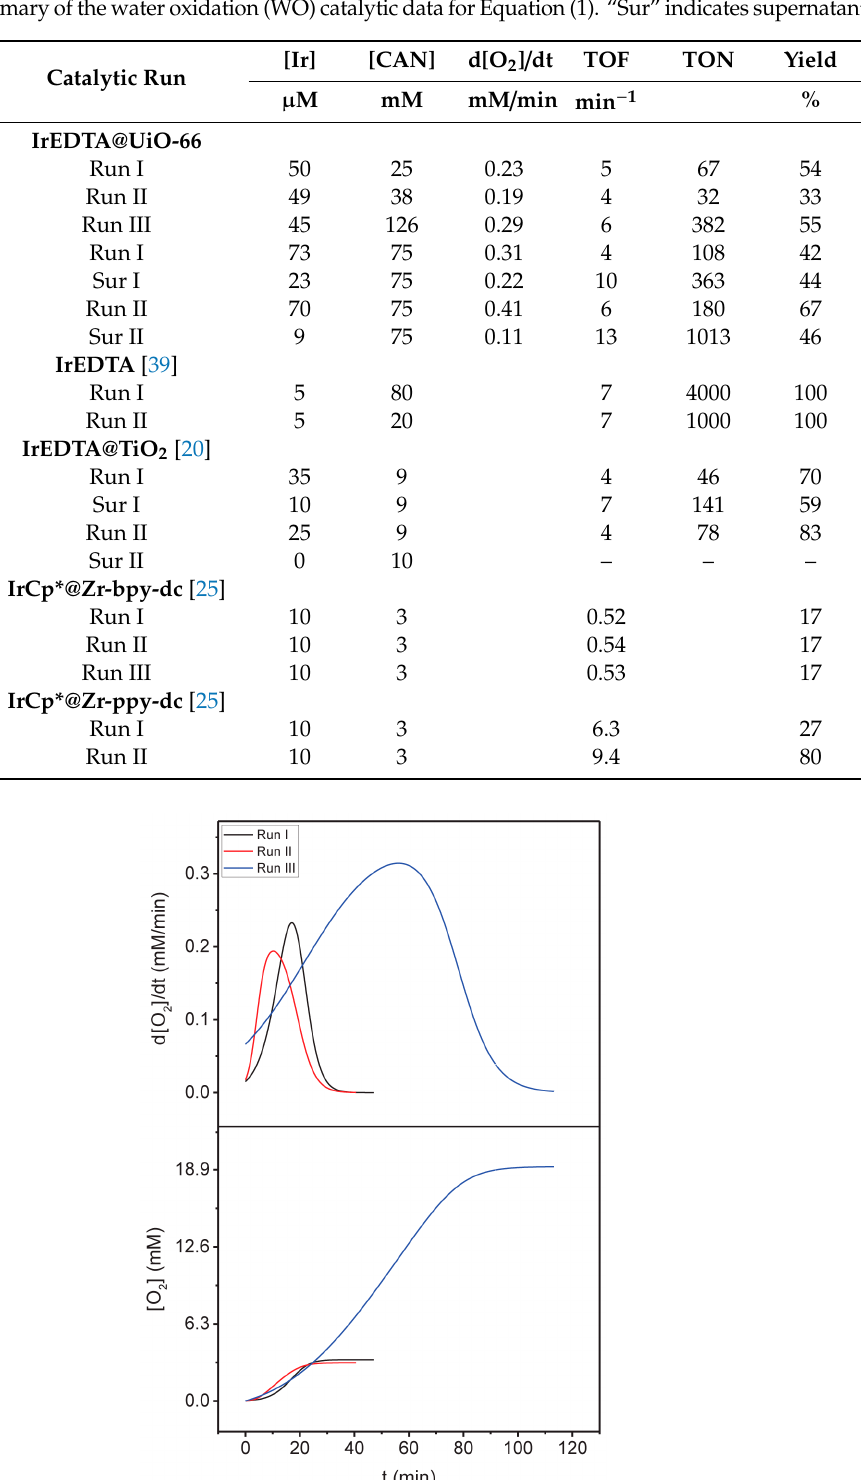
Table 1. Summary of the water oxidation (WO) catalytic data for Equation (1). “Sur” indicates supernatant.